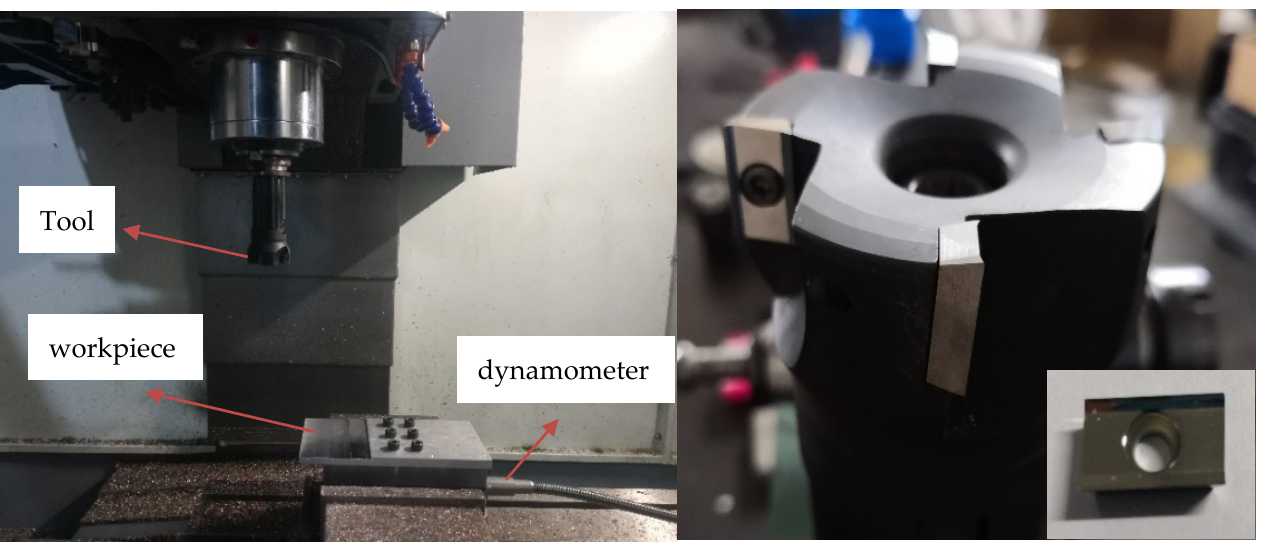
Figure 1. Experimental setup for high-speed milling.